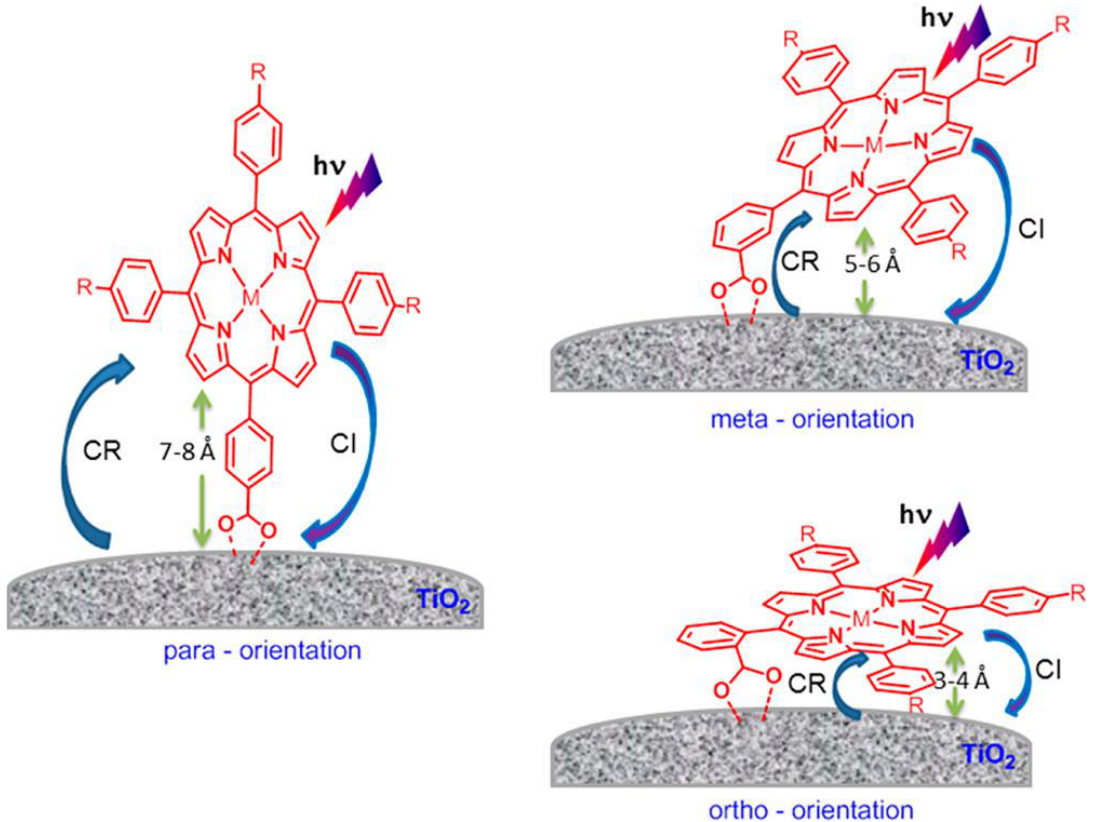
Figure 15. Relative orientation of para -, meta- and ortho- carboxyphenyl functionalized porphyrin adsorbed on a TiO 2 surface. Key photochemical events responsible for cell performance are also shown (CI, charge injection; CR, charge recombination). Reproduced from reference [79] with permission from the American Chemical Society, copyright 2013.